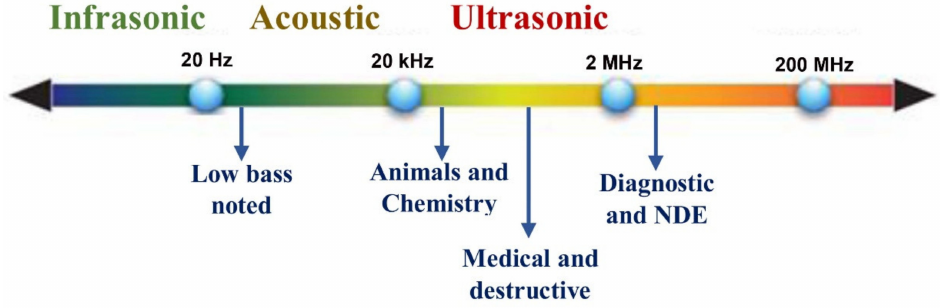
Figure 8. Approximate frequency ranges corresponding to sound, with rough guide of some